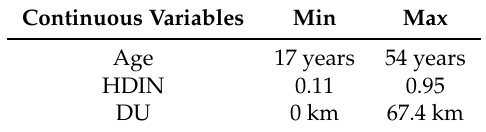
Table 1. Continuous variables with the corresponding min and max values observed.